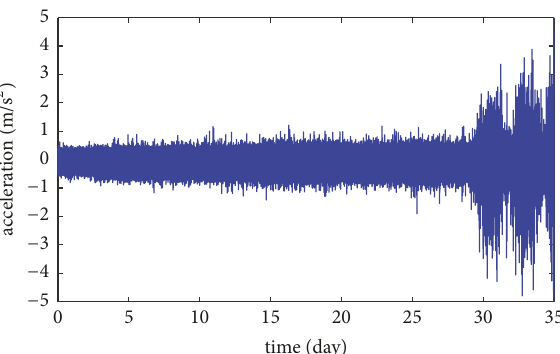
Figure 3: Bearing 3 run-to-failure vibration signals.